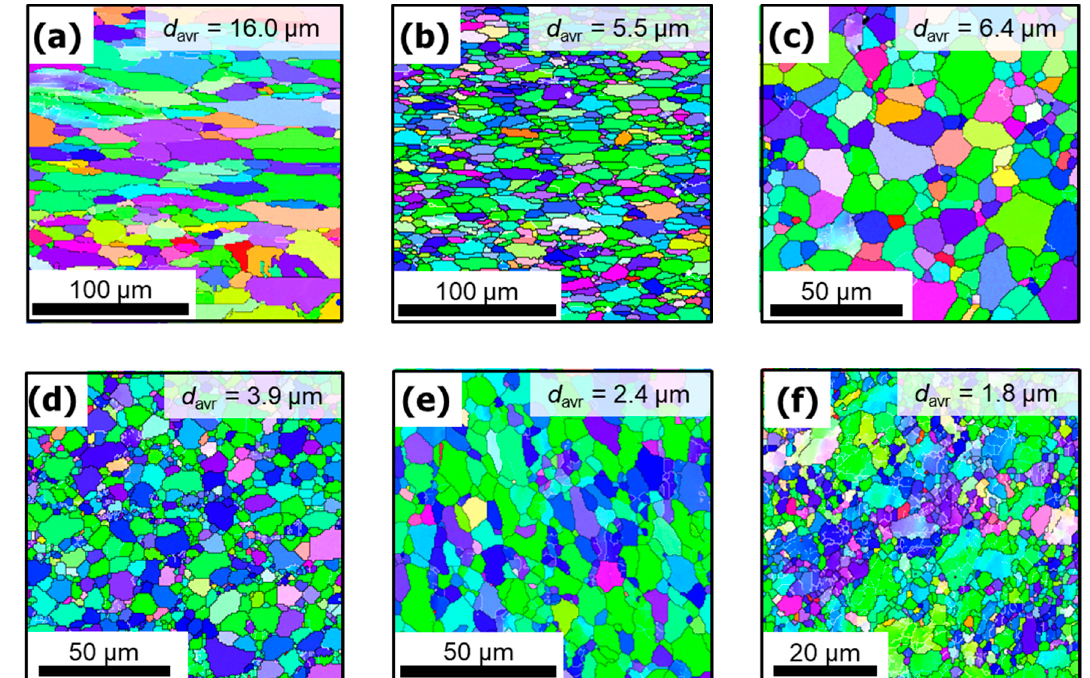
Figure 2. EBSD inverse pole figure maps of the investigated TM10 Mg alloys: ( a ) TM10-1P, ( b ) TM10-2P, ( c ) TM10-3P, ( d ) TM10-4P, ( e ) TM10-5P, and ( f ) TM10-6P. The images are normalized to the RD. “ d avr ” indicates the average grain size, as determined by the EBSD analysis.